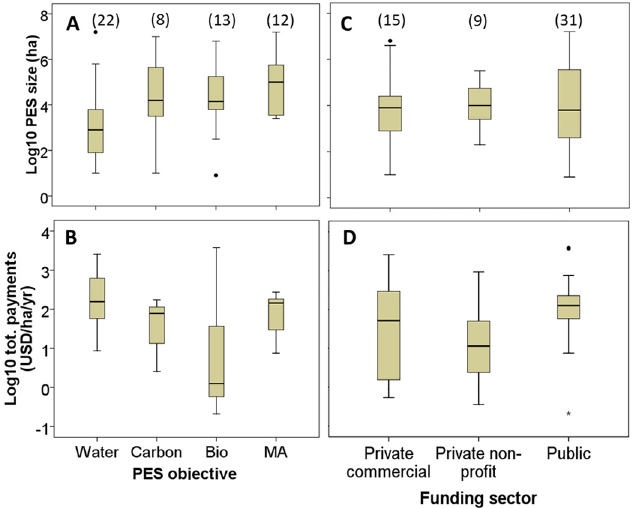
Fig 3. Box plot showing the distribution — median, interquartile range (box), upper and lower values below 1.5 interquartile range and outliers, of total cash payments and PES area size in a logarithmic (base 10) scale by ES targeted (sub-Figs A and B) and economic sector (C and D). In parenthesis are number of observation for each category.